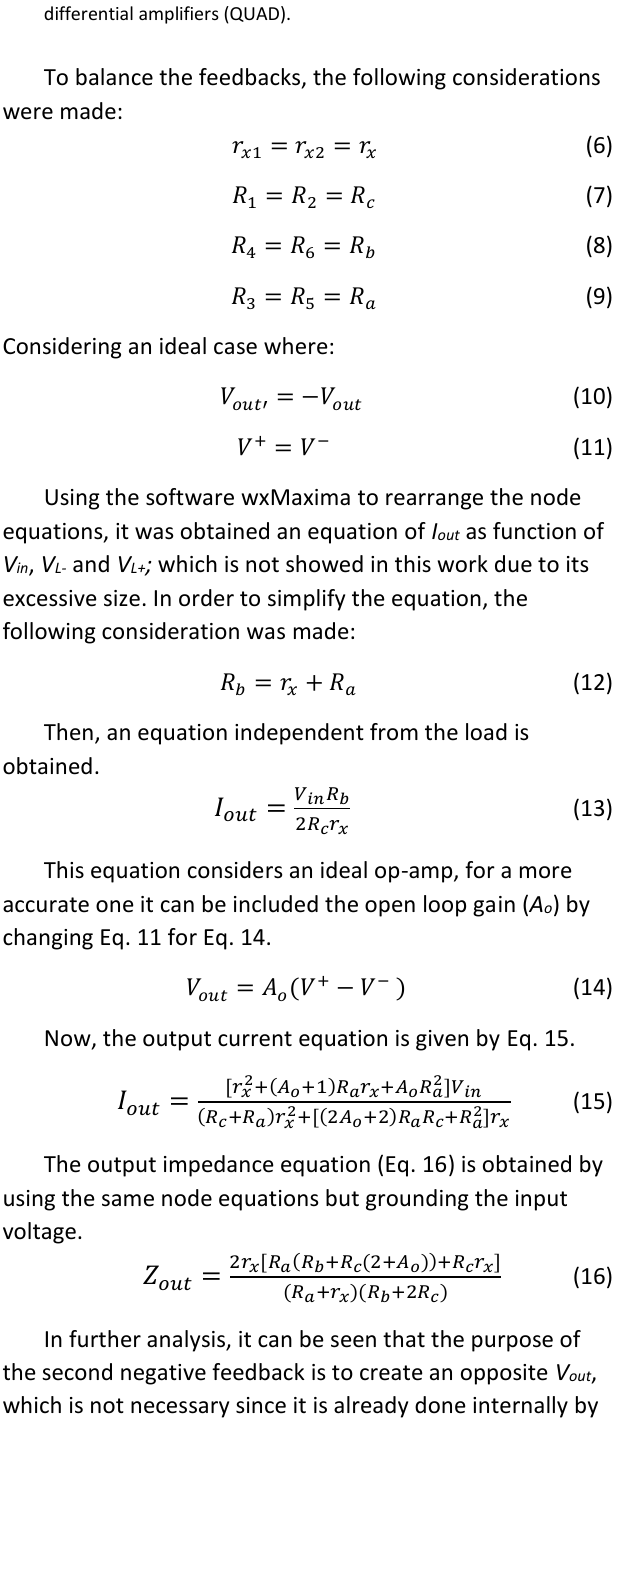
Fig.7: Quad-Feedback Enhanced Howland Current Source with differential amplifiers (QUAD).